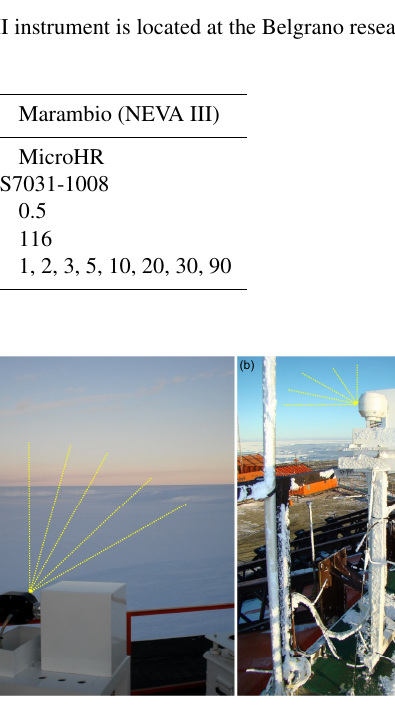
Figure 2. INTA’s MAX-DOAS instruments mounted at the two Antarctic stations. The outdoor unit of the MAX-DOAS instrument installed at Belgrano is shown in (a) while the one at Marambio is shown in (b) . By scanning the atmosphere at different elevation an- gles (yellow lines), vertical information of aerosols and trace gases can be